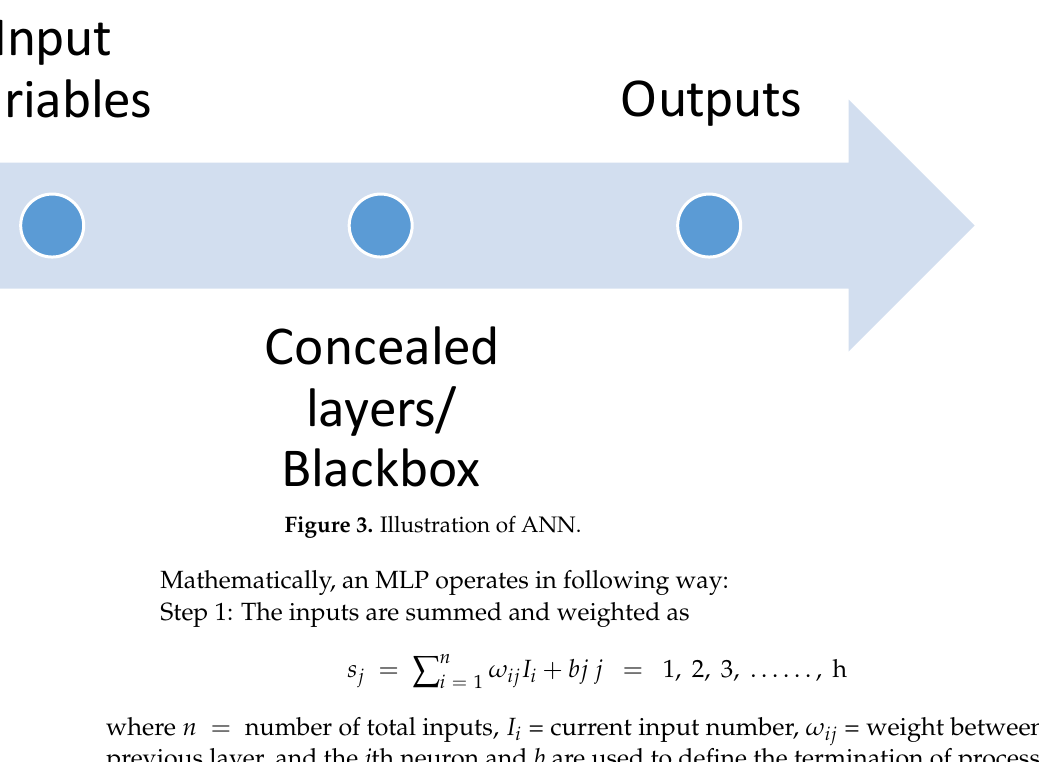
Figure 3. Illustration of ANN .